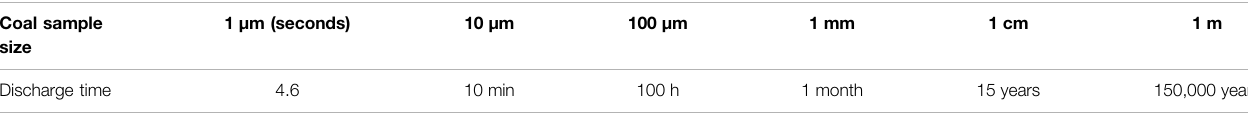
TABLE 1 | Desorption time of 90% gas from lump coal with different particle sizes. Coal sample